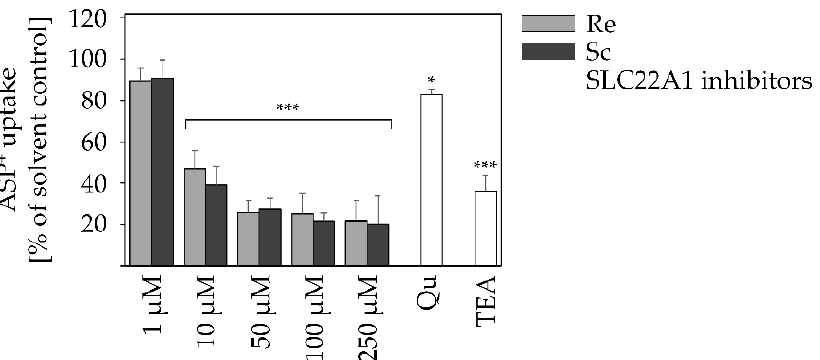
Figure 5. Reduction of fluorescent SLC22A1 substrate (ASP + ) uptake in retrorsine- and senecionine- incubated HepaRG cells in a concentration-dependent manner. Differentiated HepaRG cells were incubated for 24 h with different concentrations (1–250 µ M) of retrorsine (bright gray bars) or senecionine (dark gray bars), respectively. The SLC22A1 inhibitors Qu and TEA were incubated for 24 h as positive controls at 100 µ M or 3 mM, respectively (white bars). ASP + -uptake is displayed as percent of solvent control as mean + SD of six independent experiments with five incubations each. 0.01% Triton X-100 was used as positive control for cytotoxicity, resulting in a decrease of cell viability below 5%. Statistical analysis was performed using one-way ANOVA, followed by Dunnett’s post-hoc test, and significant differences are depicted as follows: * p < 0.05, *** p < 0.001. Re, retrorsine; Sc, senecionine.